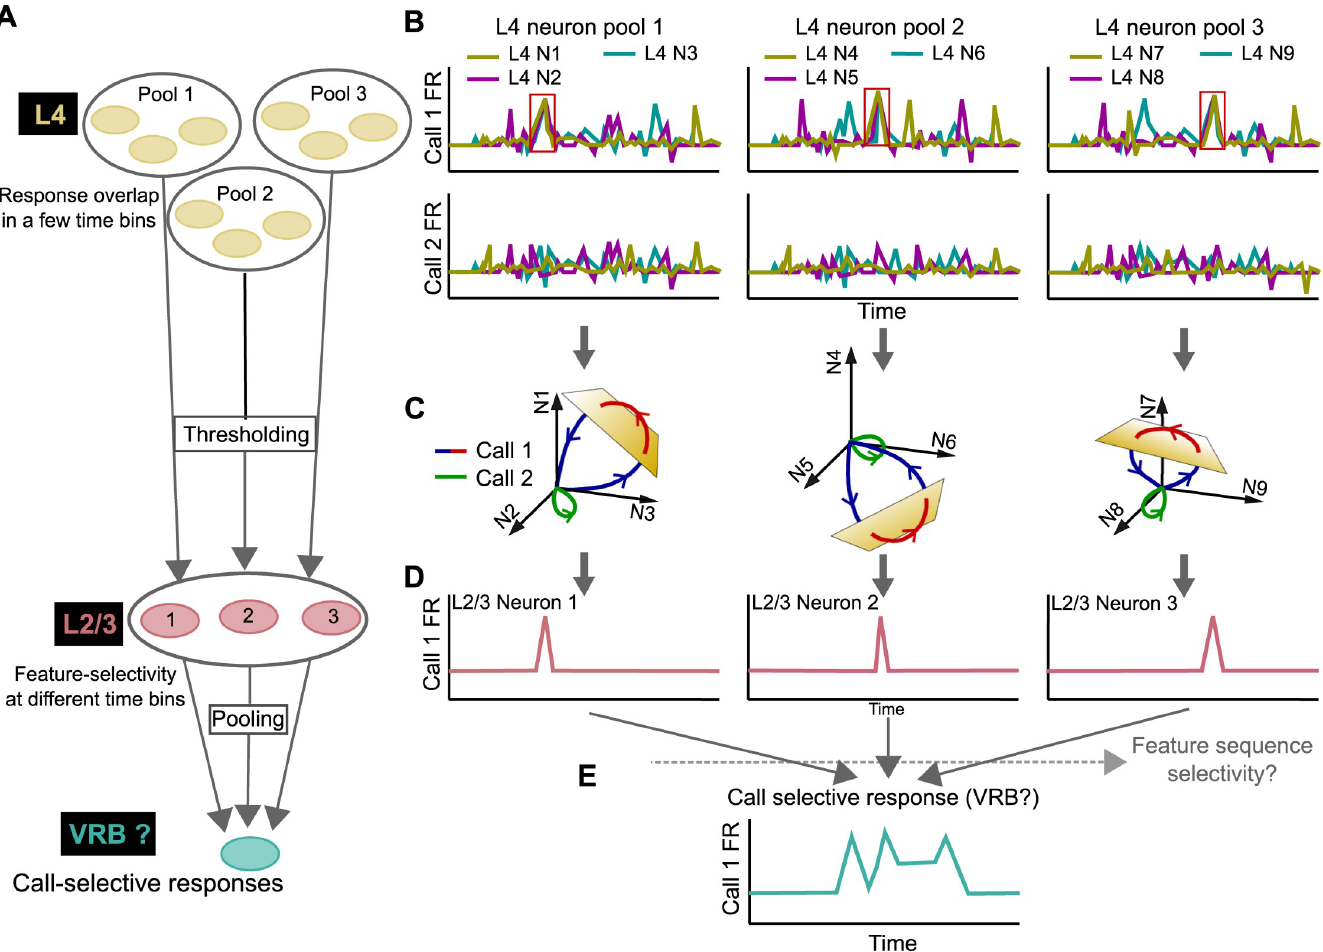
Fig 9. Working model of generating call selectivity in the auditory cortical hierarchy. (A) Alternating nonlinear (high threshold) and more linear (pooling) stages that could result in call-selective responses in secondary cortex. (B) Schematic of nonselective A1 L4 neural responses that could show overlap in a few time bins. (C, D) A high threshold could be applied to different pools of A1 L4 neurons to result in A1 L2/3 responses that are selective to specific call features. (E) A more linear operation could pool over A1 L2/3 neurons that are selective for features belonging to the same call category to result in call category-selective secondary cortical